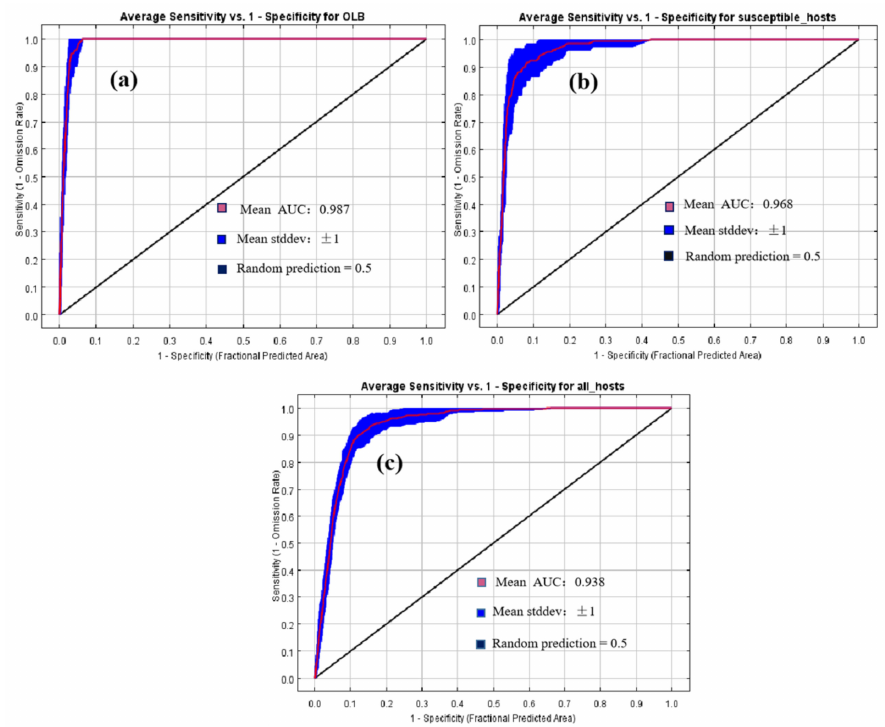
Figure 2. AUC values of the test on the applicability of three MaxEnt models for M. raddei (oak longhorned beetle, OLB) ( a ); for susceptible hosts of M. raddei ( Q. mongolica and Q. liaotungensis ) ( b ); and for all hosts of M. raddei ( c ).